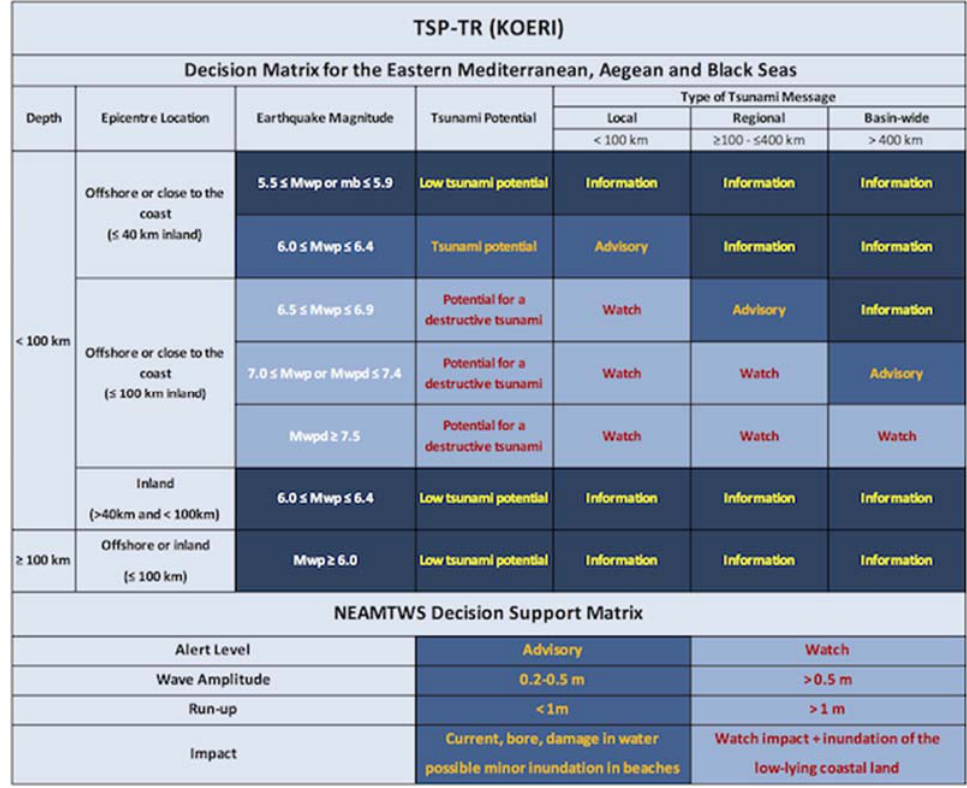
Figure 3. KOERI–RETMC decision matrix (top) and NEAMTWS decision support matrix used in KOERI–TSP operations.